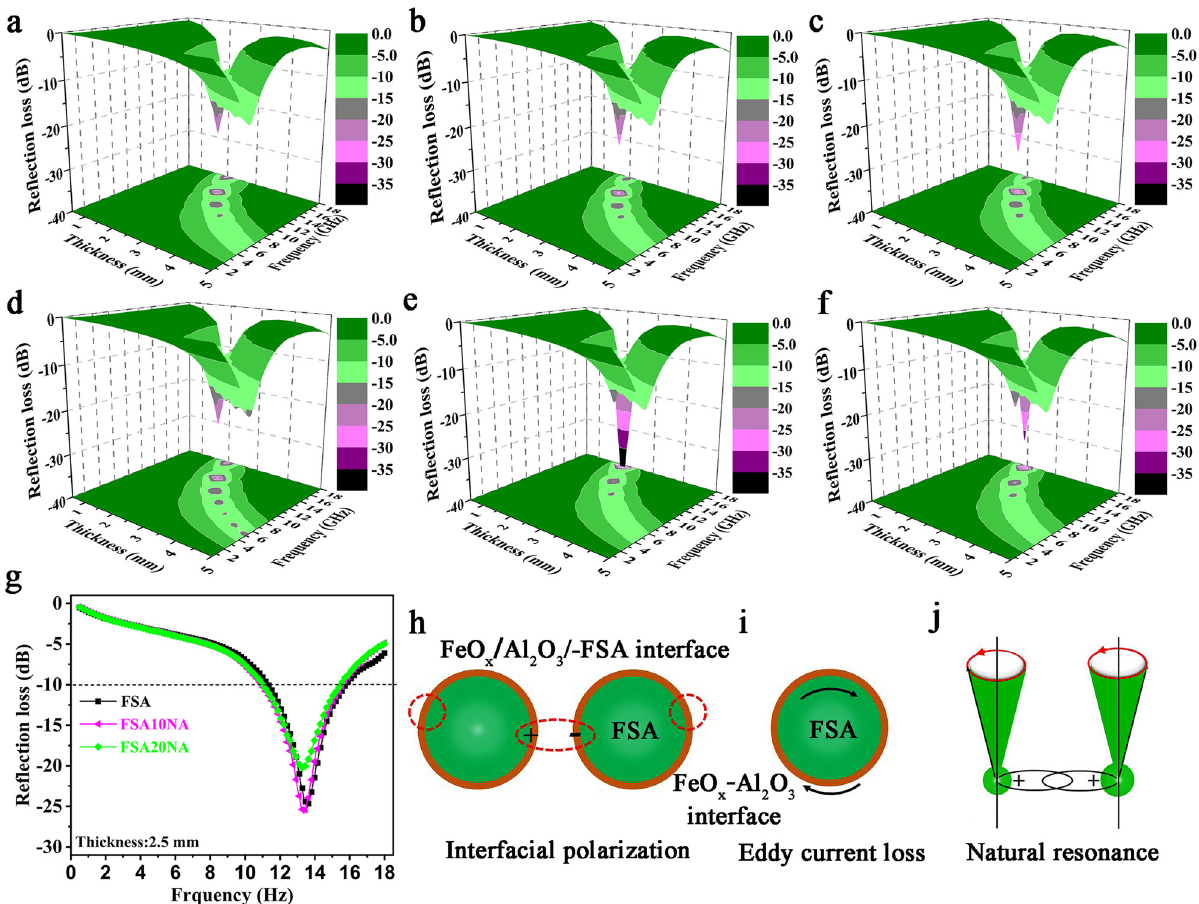
Figure 5: Frequency and thickness dependence of simulated 3D color maps of ( a ) FSA, ( b ) FSA1NA, ( c ) FSA5NA, ( d ) FSA10NA, ( e ) FSA20NA, and ( f ) FSA30NA. ( g ) RL curves of FSA, FSA1NA, FSA5NA, FSA10NA, FSA20NA, and FSA30NA in 0.5 – 18 GHz at a thickness of 2.5 mm. Schematic of ( h ) interfacial polarization, ( i ) eddy current, and ( j ) natural resonance in FSA - based 3D